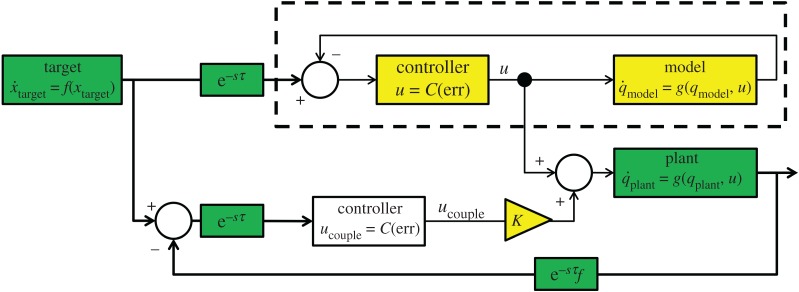
The parallel system. The dynamics of the plant (g(qplant,u)) and controller (u=C(err)) are replicated in an internal model (delineated by a dashed box) that uses instantaneous feedback to produce the primary control signal u. Green blocks represent unchangeable elements of the underlying system, while yellow blocks have been added to enable anticipation. The delayed-feedback from the plant provides the ‘slave’ component for the coupling term, which is transformed by the controller into a secondary control signal (ucouple) that is scaled by the coupling constant K. This drives the plant itself to anticipate the target.